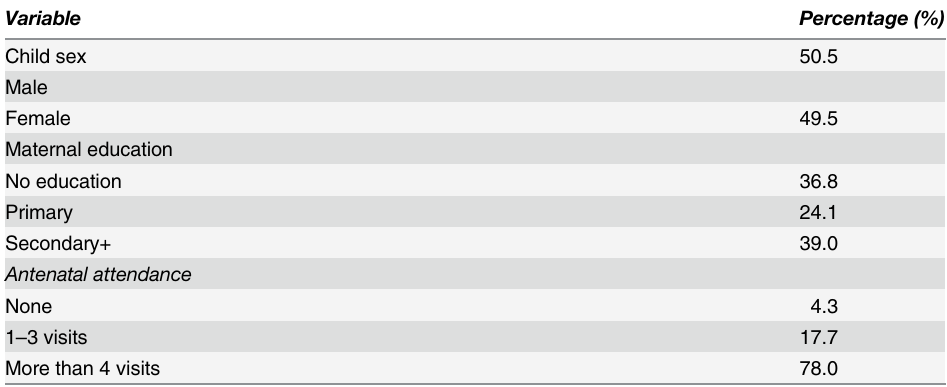
Table 2. Selected characteristics of the study sample (n = 1187), categorical variables, percentages (%).